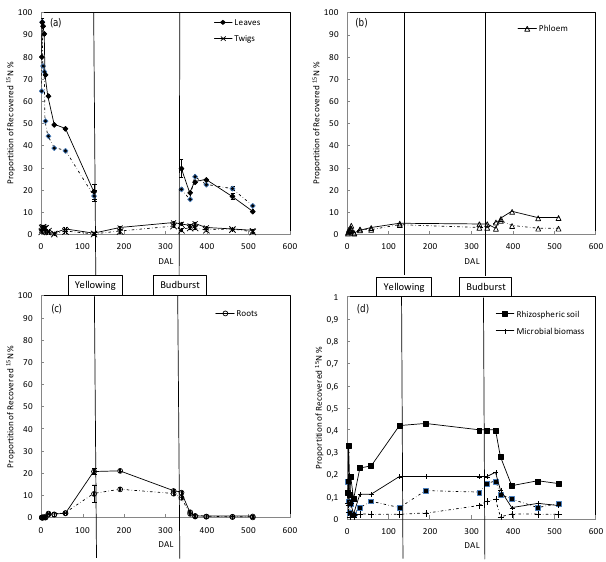
Figure 1. Partitioning of recovered 15 N (PRN%) from the sam- pled compartments following the first labelling campaign, i.e. from 27 May 2009 to 20 October 2010. (a) Leaves ♦ and twigs × , (b) phloem (cid:49) , (c) fine roots ○ , (d) rhizospheric soil ■ and micro- bial biomass + (for those compartments the Y axis was adjusted to 1). DAL: days after labelling. The two lines, continuous and dot- ted, correspond to tree 1 and tree 2. Vertical bars indicate standard